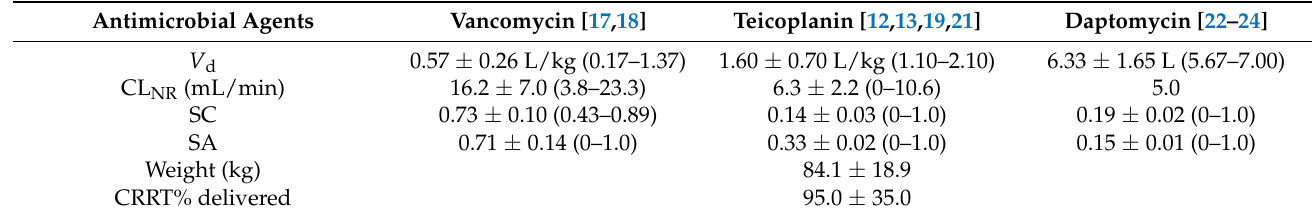
Table 1. Demographic and pharmacokinetic